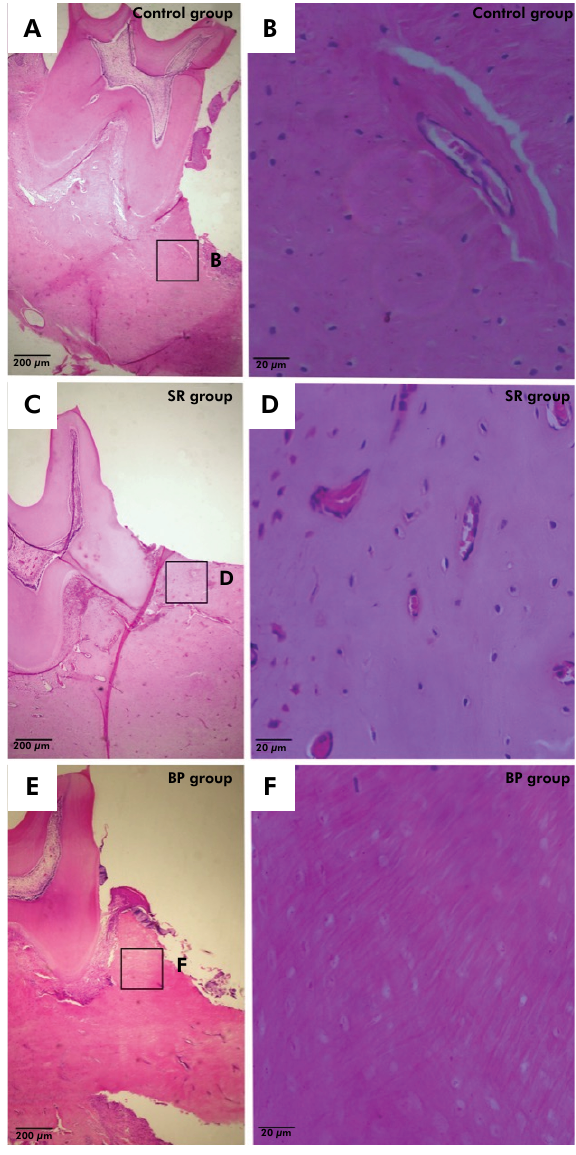
Figure 5. Histological features of control (A, B), SR (C, D), and BP (E, F) groups. Observe the presence of adjunct empty gaps of osteocytes in the BP group, characteristic of osteonecrosis.